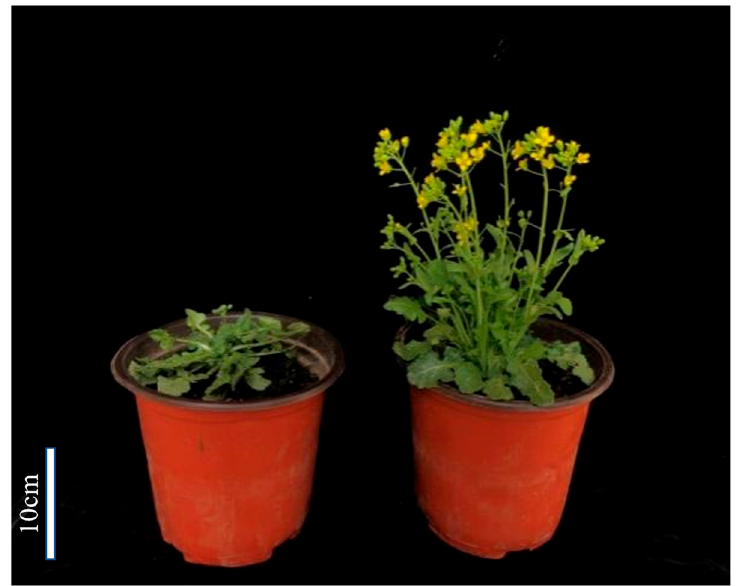
Figure 6. Phenotypes of the Brcd1 YS in response to exogenous gibberellin (GA 3 ) treatment. The dwarf mutant ‘ Brcd1 YS ’ ( left ) and dwarf mutant ‘ Brcd1 YS ’ treated with GA 3 ( right ) grown under natural conditions. The plants are shown at 45 days after sowing (DAS). Scale bars = 10 cm.